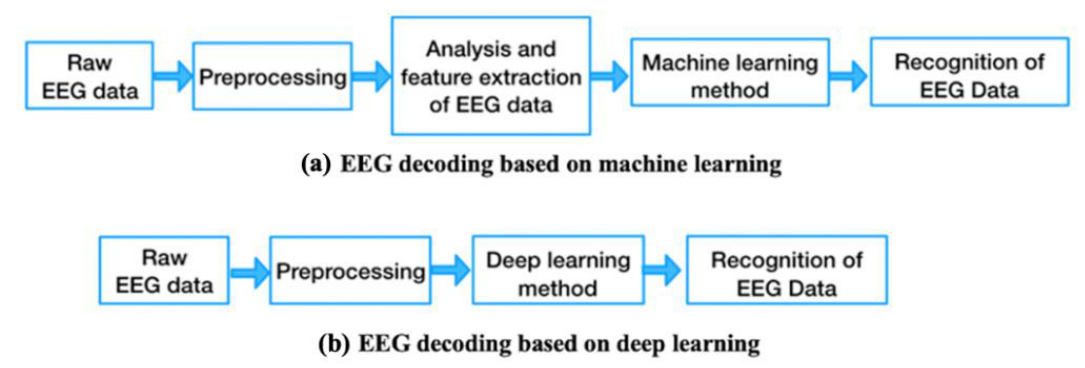
Figure 1. Experimental flowchart of EEG signal processing based on machine learning and deep learning.